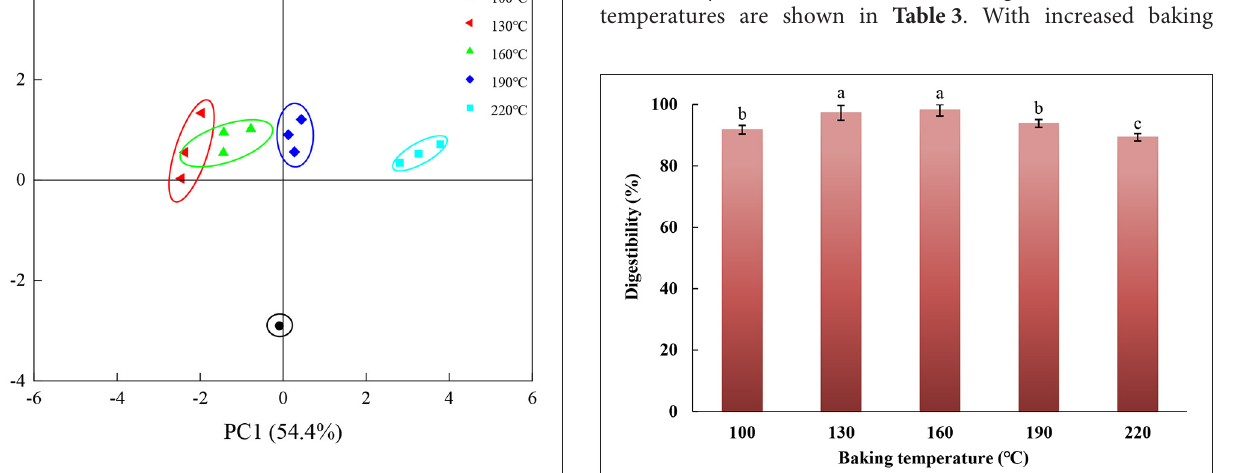
Data are expressed as mean ± standard deviation. Values with different letters in the same column indicate significant differences at P < 0.05.